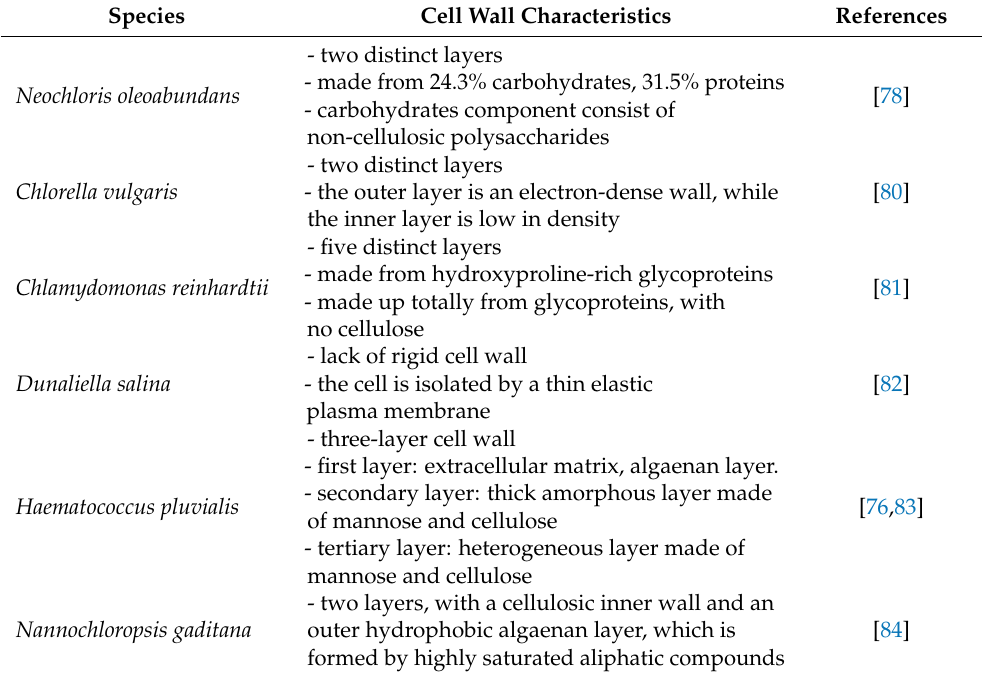
Table 3. Cell wall characteristic for several microalgae species. Species Cell Wall